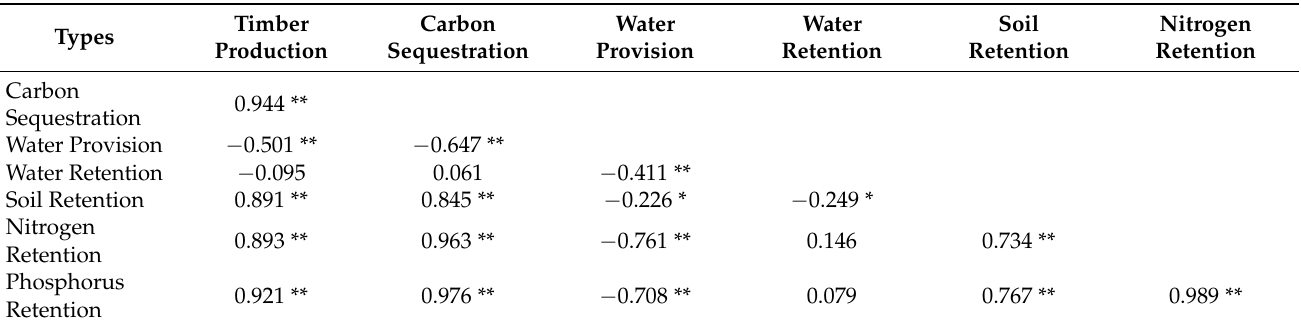
Table 1. Pair-wise spatial interactions among ecosystem